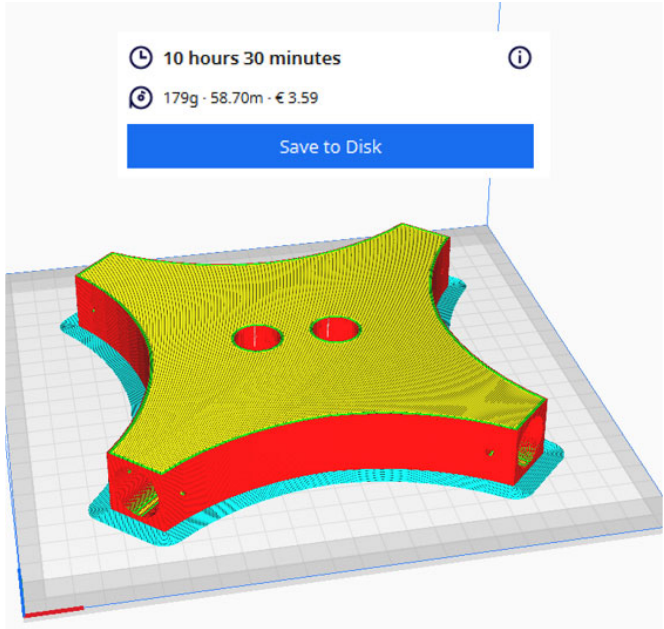
Figure 7. Simulation of mirror base printing.